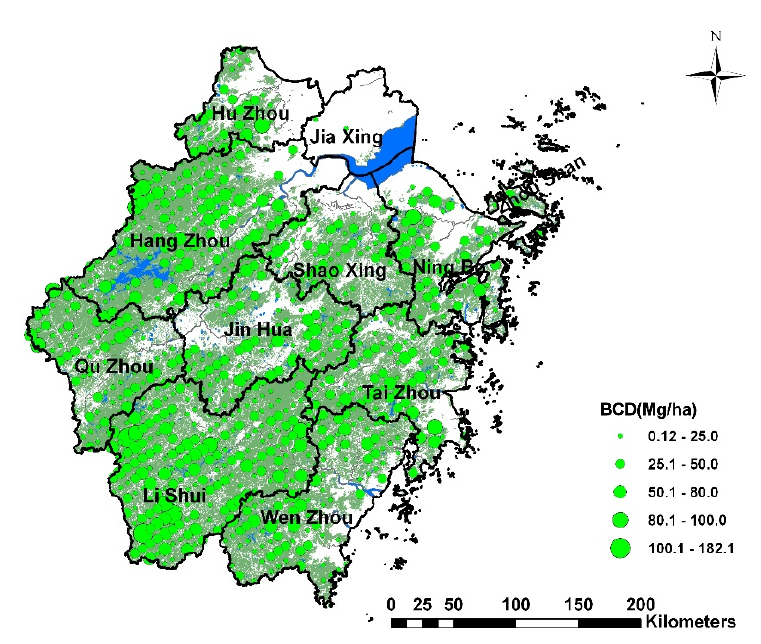
Figure 3. Symbol map of forest biomass carbon (FBC) density values in Zhejiang